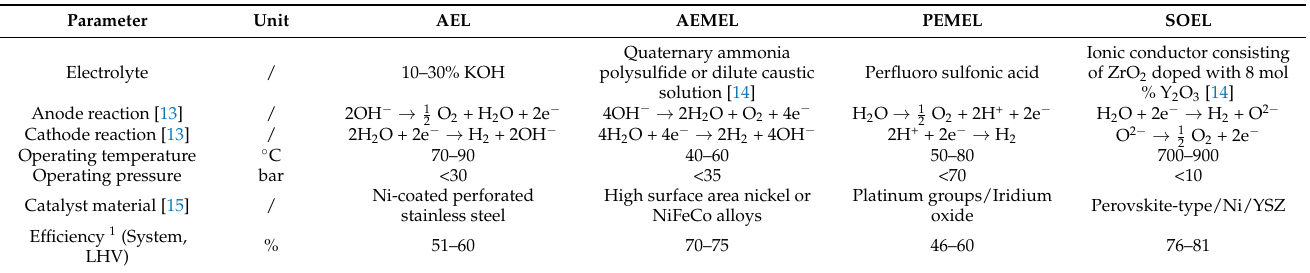
Table 1. Technical characteristics and selected parameters of AEL, AEMEL, PEMEL, and SOEL technology according to the recent literature [13]. If not specifically indicated, the values indicate representative values in line with